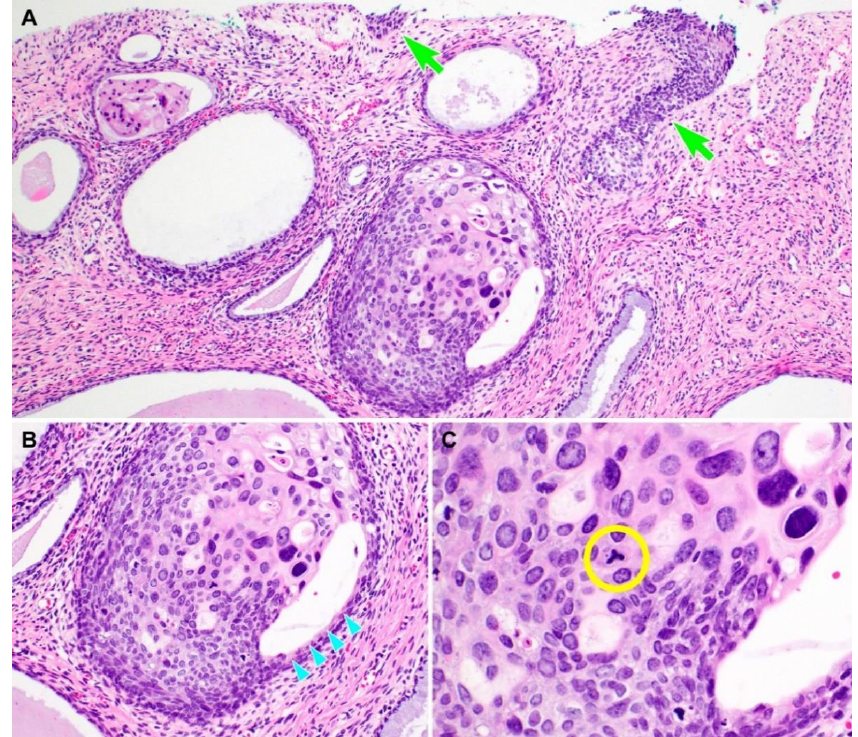
Figure 1. Histological features of pleomorphic high-grade squamous intraepithelial lesion (PHSIL). ( A ) Compared to conventional HSIL (two light green arrows), PHSIL (middle lower) displays significant nuclear enlargement and hyperchromasia that is easily identifiable at low-power magnification. ( B ) PHSIL exhibits expansile involvement of the endocervical gland. The presence of residual endocervical glandular epithelium along the luminal surface (four light blue arrowheads) indicates the intraepithelial nature. ( C ) An abnormal mitotic figure is detected (yellow circle). Hematoxylin and eosin staining. Original magnification: ( A ) = 100 × , ( B ) = 200 × , ( C ) = 400 ×